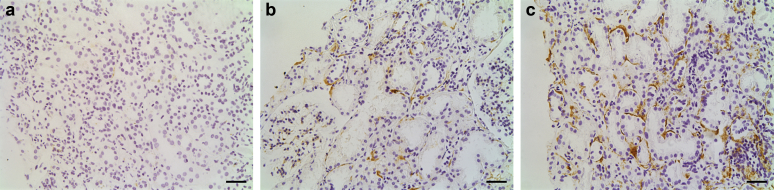
Representative images of tubular basement membrane C5b-9 staining. (a) Grade 0 staining in a case with 0% interstitial fibrosis and tubular atrophy (IFTA). (b) Grade 1 staining in a case with 15% IFTA. (c) Grade 2 staining in a case with 30% IFTA. The presence of IFTA positively correlated with the intensity of C5b-9 staining (r = 0.50, P = 0.0001). Original magnification ×20. Bar = 50 μm. To optimize viewing of this image, please see the online version of this article at www.kidney-international.org.